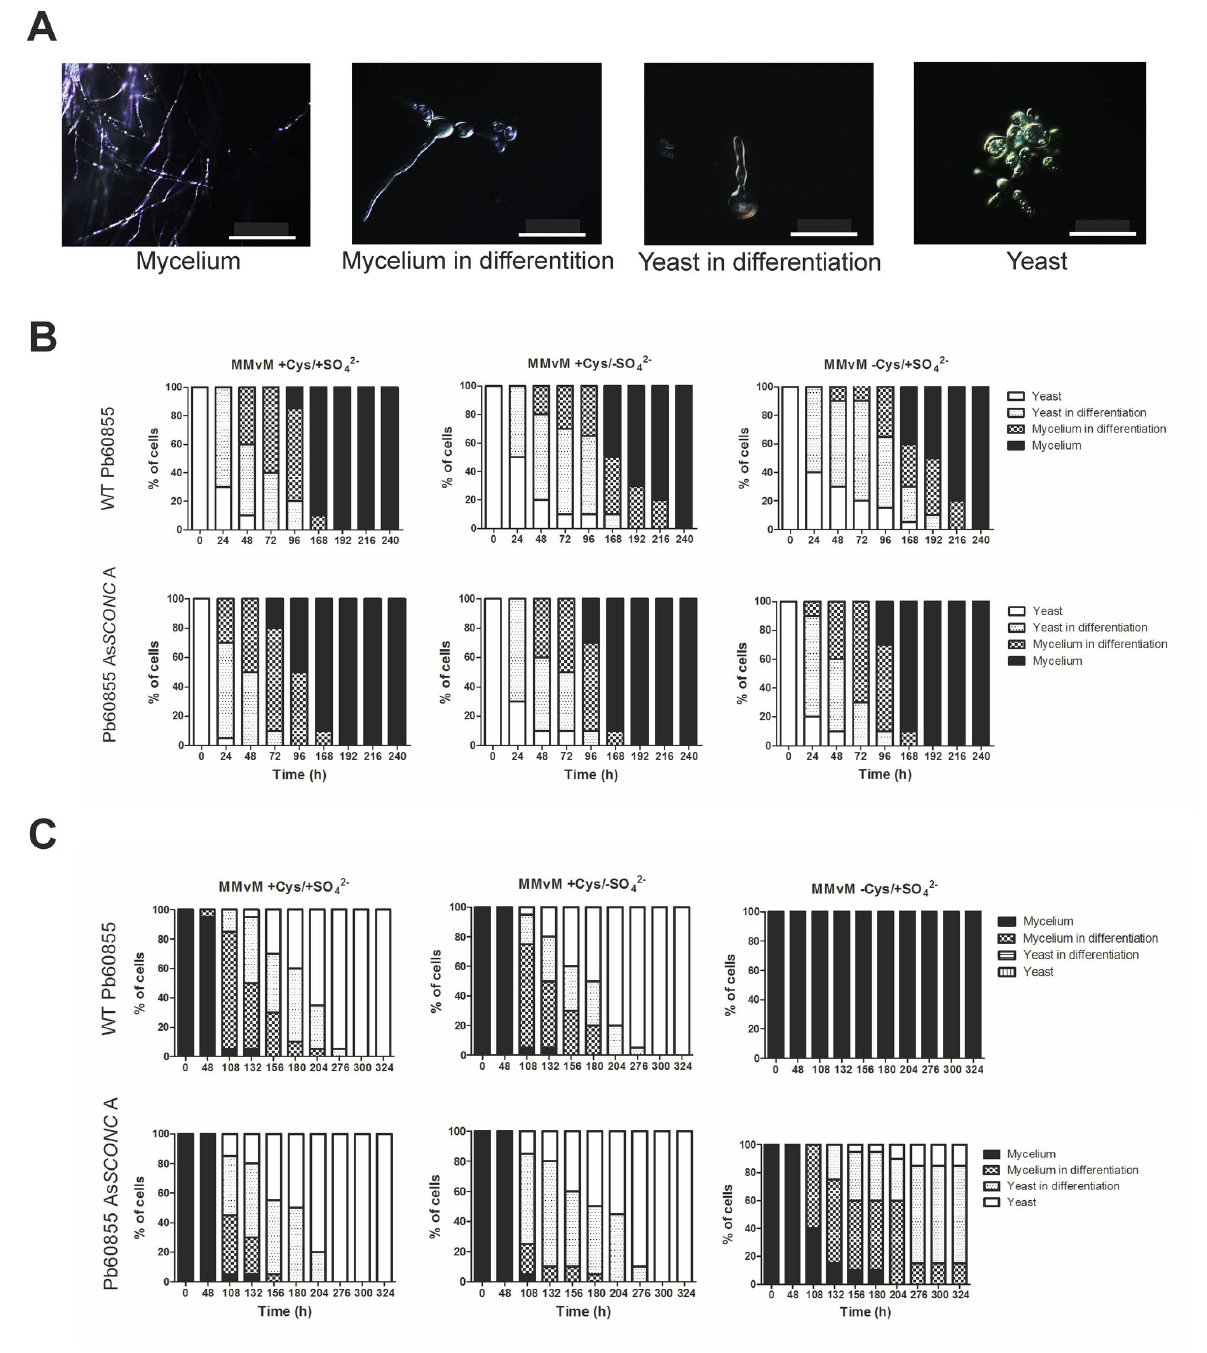
Figure 3. Down-regulation of SCONC in P. brasiliensis allows mycelium-to-yeast transition in the absence of organic sulfur compounds. ( A ) Representative DIC pictures of each morphotype considered during the morphological transition. Magnification: x40 (White bars represent 200 µm). ( B ) Evaluation of Pb60855 and Pb60855 As SCONC A morphotypes during yeast-to-mycelium transition at 26°C in complete MMvM (MMvM +Cys/+SO 42- ), MMvM without inorganic sulfur compounds supplementation (MMvM +Cys/-SO 42- ) and MMvM without organic sulfur compounds supplementation (MMvM -Cys/+SO 42- ); ( C ) Evaluation of Pb60855 and Pb60855 As SCONC A morphotypes during mycelium-to-yeast transition at 37°C in complete MMvM (MMvM +Cys/+SO 42- ), MMvM without inorganic sulfur compounds supplementation (MMvM +Cys/-SO 42- ) and MMvM without organic sulfur compounds supplementation (MMvM -Cys/+SO 42- ). doi: 10.1371/journal.pone.0074725.g003 PLOS ONE |